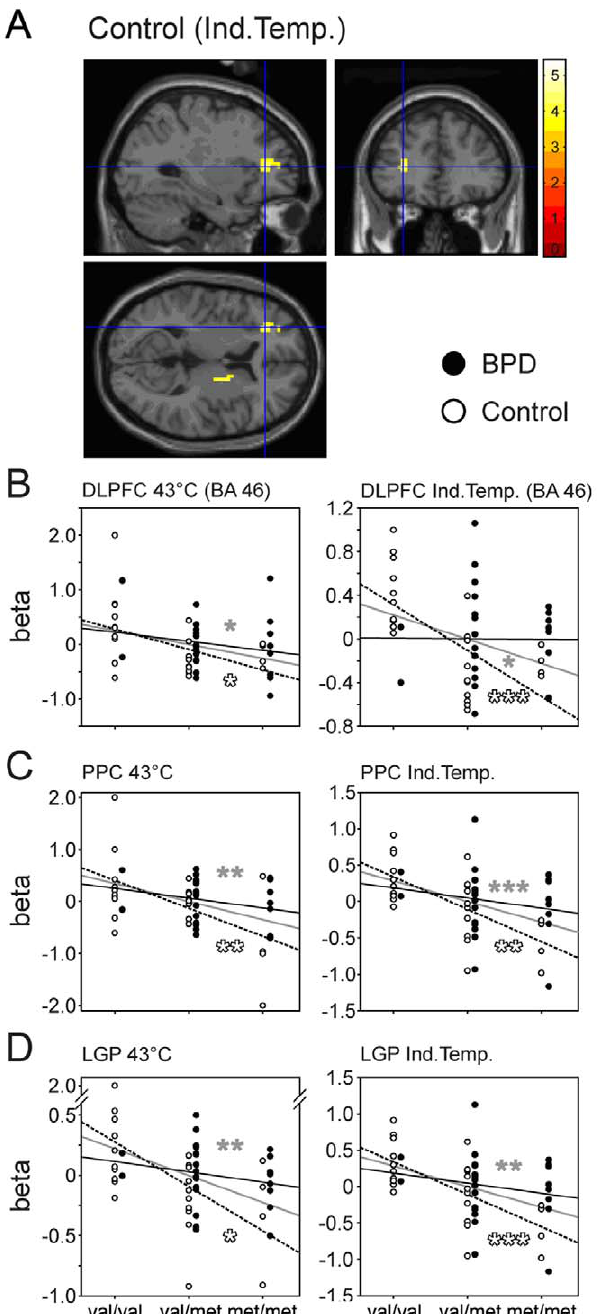
Figure 3. Association between COMT genotype and fMRI activation during painful stimulation in frontal brain areas. Significant correlations were observed for both stimulus conditions within the dorsolateral prefrontal cortex (DLPFC; A,B). Furthermore, the posterior parietal cortex (PPC; C) and the lateral globus pallidus (LGP; D) also displayed significant correlation during both conditions. Statistics and regression lines for group means are shown in gray (all 50 subjects), black (BPD), and dashed (Control), respectively; significant Pearson product moment correlation * p , 0.05, ** p , 0.01, *** p , 0.001, versus r=0.